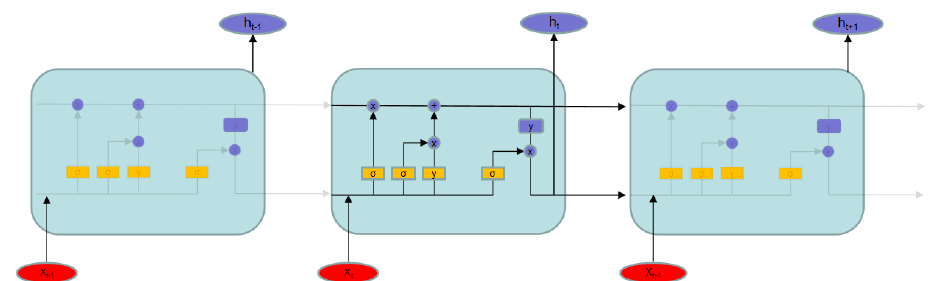
Figure 4. LSTM cell structure diagram.